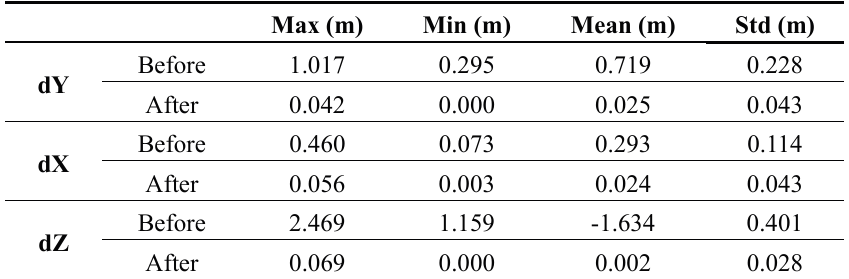
Table 3. Statistics of the independent check points.